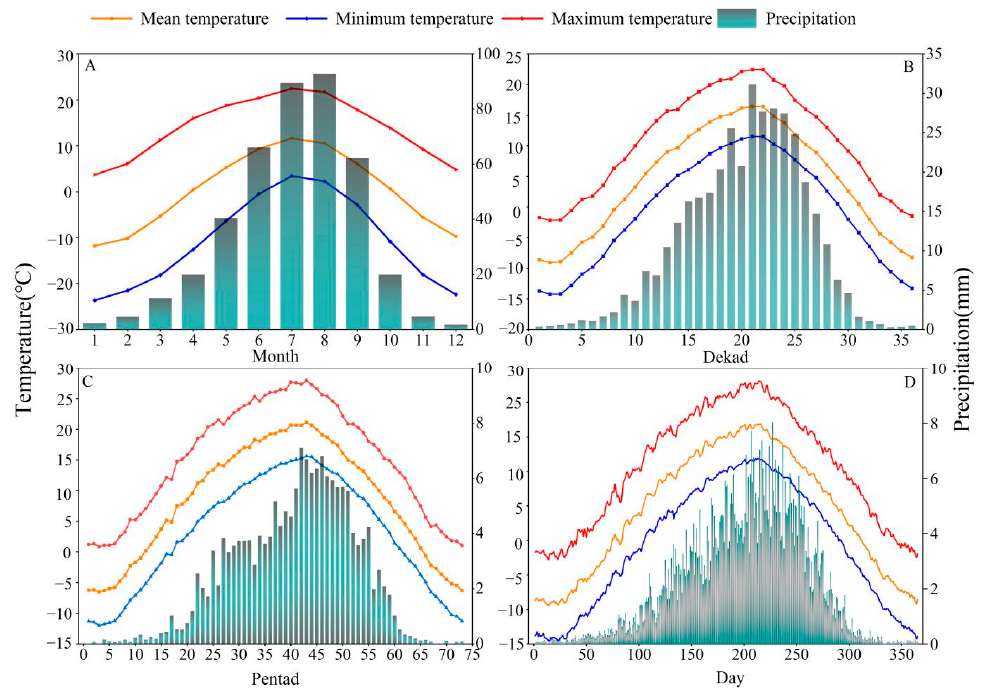
Figure 2. Variation trends in climate factors in the study area at daily, pentad, dekad, and monthly timescales during 1960–2018. ( A ) Trend in climate factors at the monthly scale, ( B ) change trend in climate factors at the dekad scale, ( C ) change trend in climate factors at the pentad scale, and ( D ) change trend in climate factors at the daily scale.